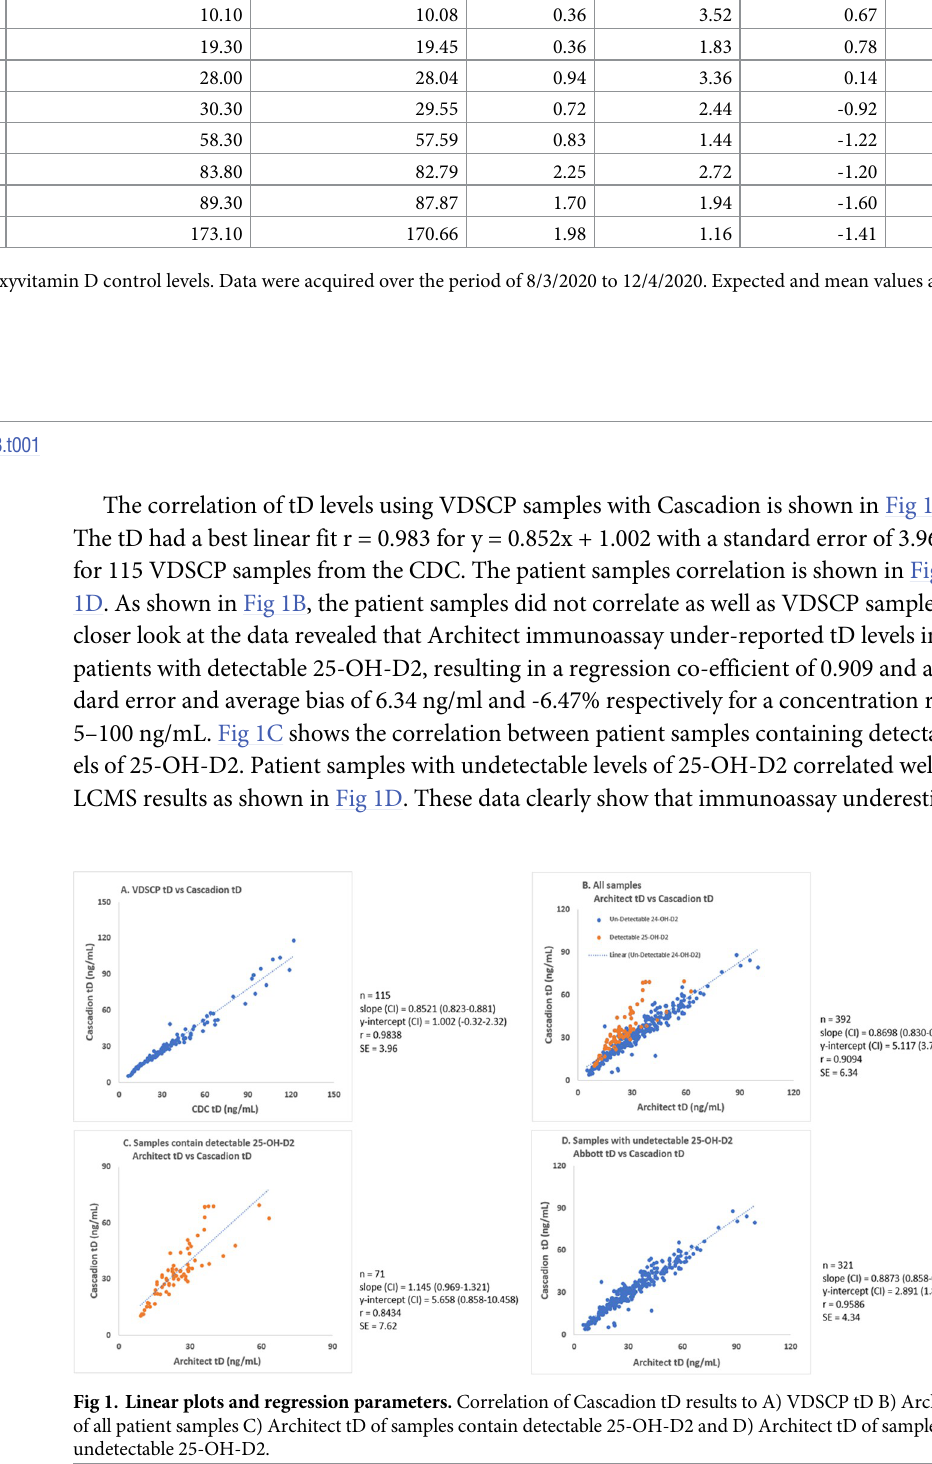
Table 1. Precision results of 25-OH-D2, 25-OH-D3, and tD control levels. Control